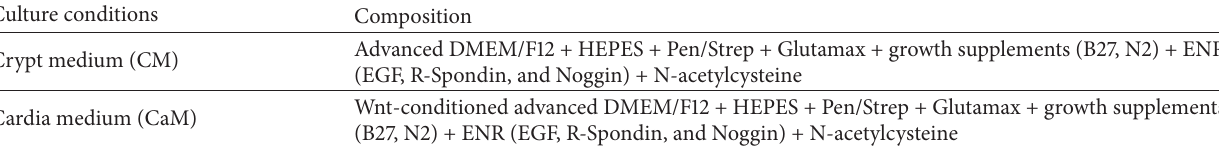
Table 1: Composition of standard media applied in the described